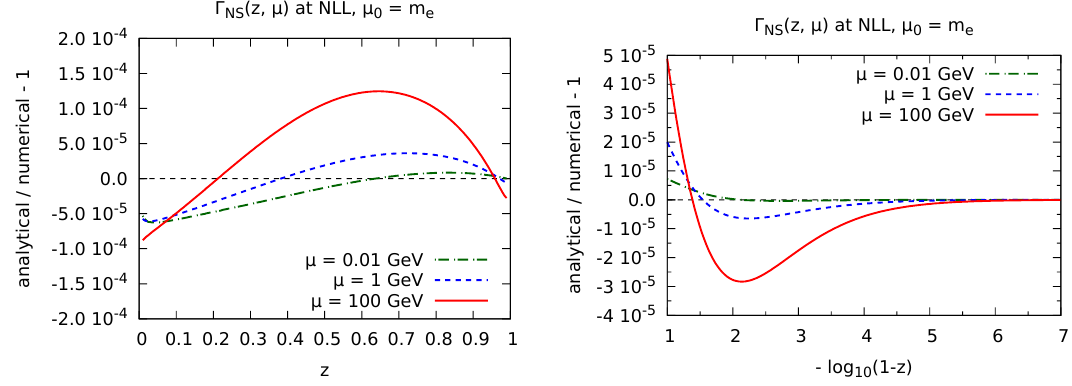
Figure 6 . Comparison between the numerical and analytical predictions for the non-singlet, for three di(cid:11)erent hard-scale choices.